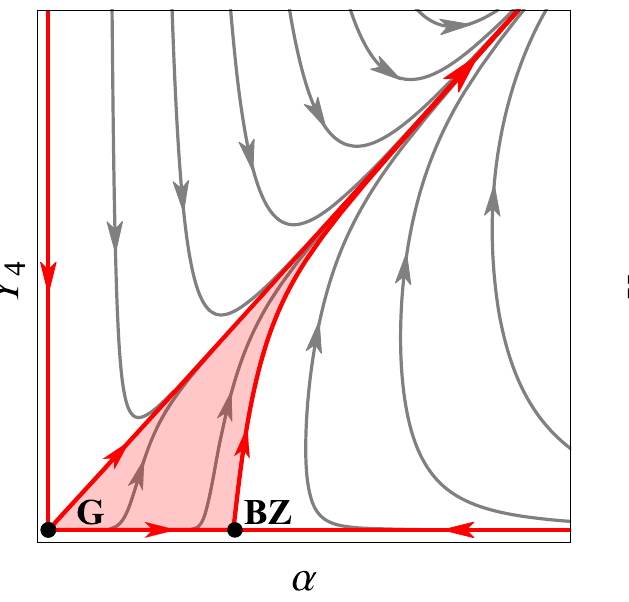
Fig. 4 Fixed points and phase diagrams of gauge–Yukawa theories with B > 0 and C > C (cid:16) > 0 at weak coupling showing asymptotic freedom with Gaussian, Banks–Zaks, and gauge–Yukawa fixed points (GY). Notice that the gauge–Yukawa fixed point attracts UV free tra- jectories emanating from the